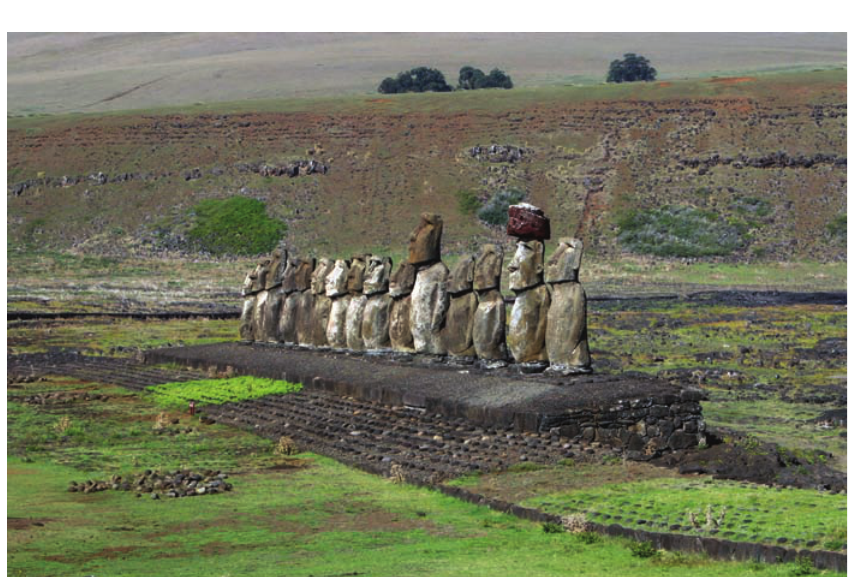
Figure 2 Tongariki is the largest ceremonial platform on Rapa Nui, with 15 statues set up on it. It was restored after destruction by an 8m tsunami following an earthquake in Chile in 1960. The tsunami carried statues weighing up to 30 tons 150m